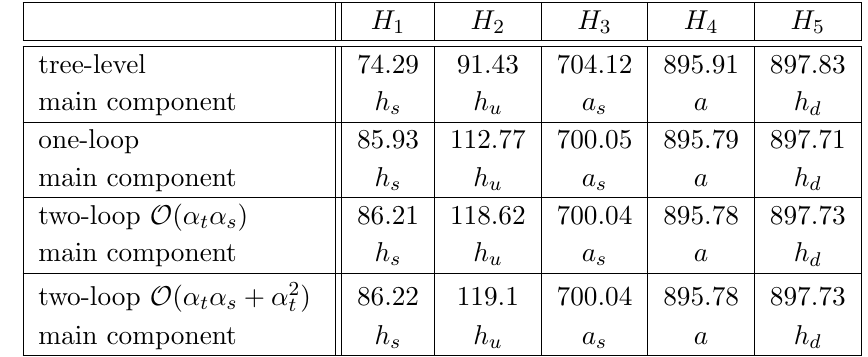
Table 3 . P1OS: mass values in GeV and main components of the neutral Higgs bosons at tree-level, one-loop, two-loop O ( (cid:11) t (cid:11) s ) and at two-loop O ( (cid:11) t (cid:11) s + (cid:11) 2 the top/stop